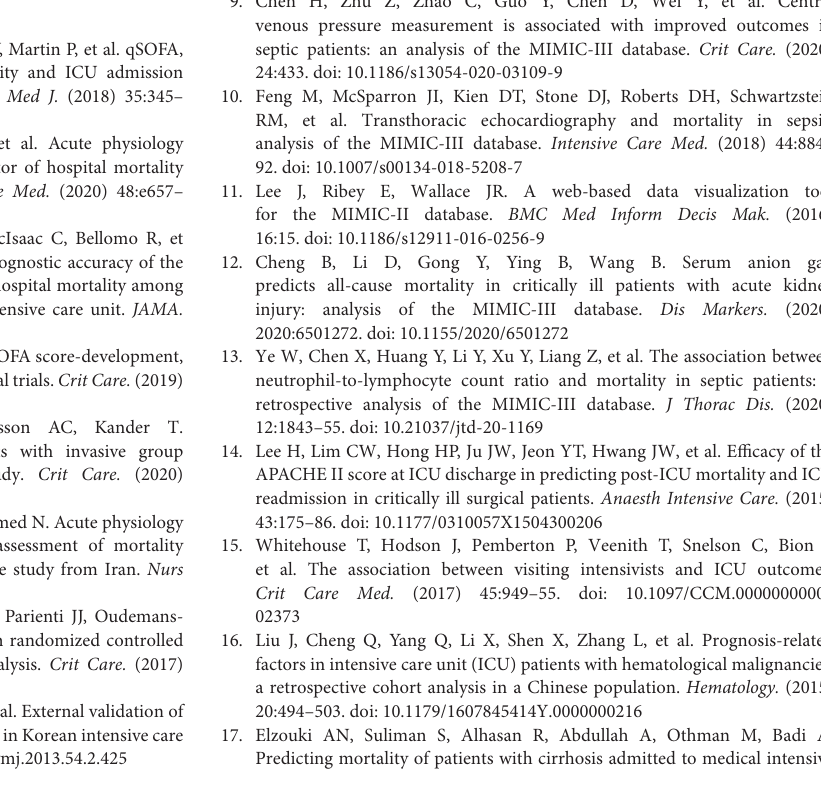
Supplementary Figure | Sequential APACHE II score as predictors of the hospital mortality of patients who were not transfered from other units or hospitals. Supplementary Table | Odds Ratios and 95% CIs for Hospital Mortality Associated With the APACHE II score in Overall Patients after adjusted for hospital day, ICU day, and MV